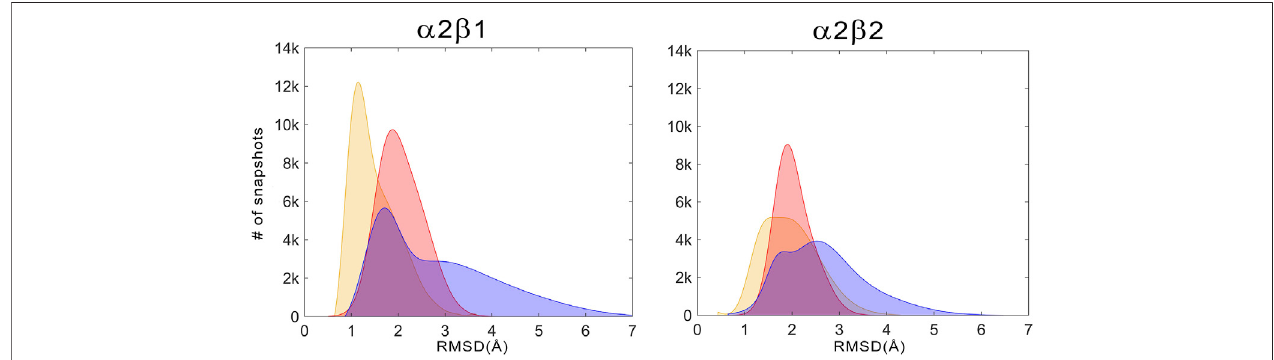
FIGURE7| Distribution ofthepositionaldeviation(RMSD;Å)ofthestructuressampledalongthetrajectoriesrunforapo (red) ,holo (blue) ,andholo+ATP (yellow) for the residues that shape the ATP-binding site (residues α 22 – α 32, α 42 – α 46, α 75 – α 79, α 142 – α 147, and α 153 – α 157). A total of 60,000 snapshots taken from the last 500 ns of MD simulations were considered for each system in the analysis.